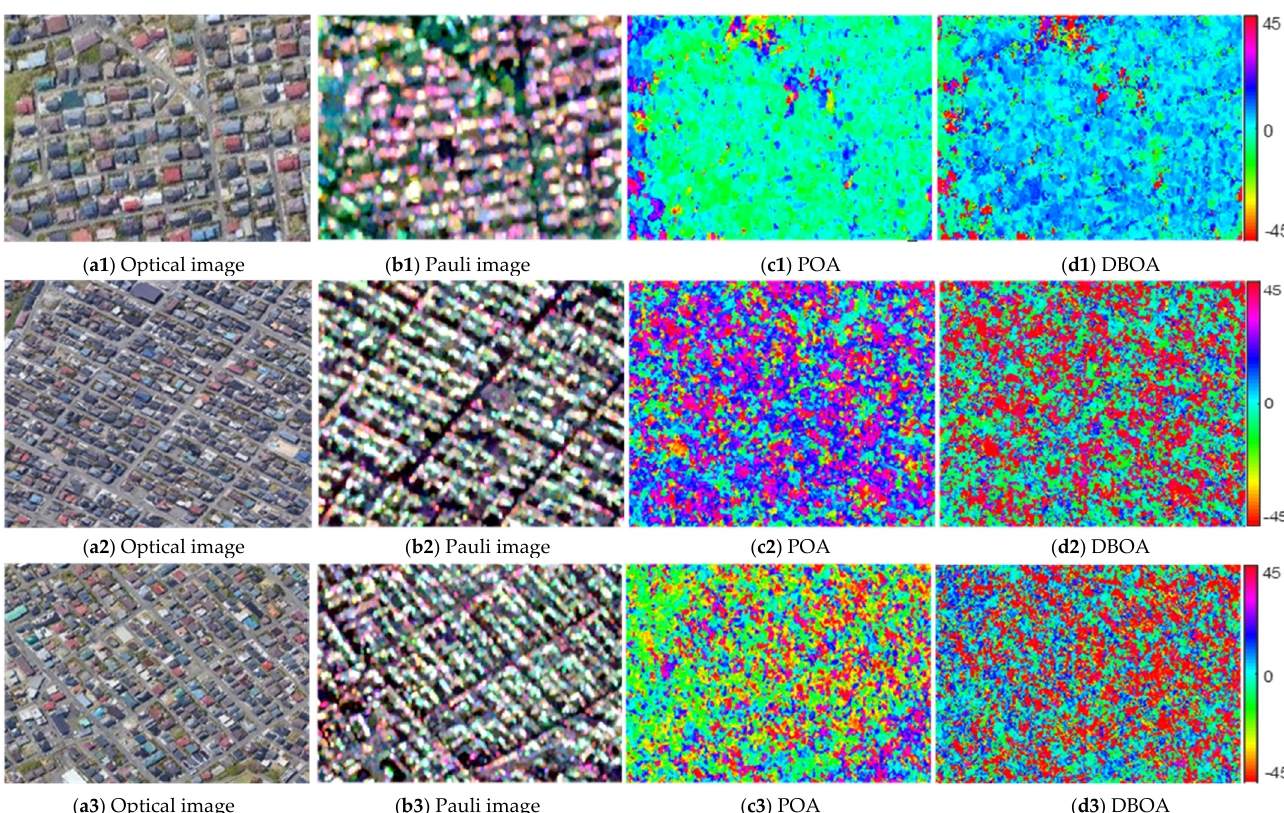
Figure 1. The optical images, Pauli images, polarization orientation angles, and double-bounce orientation angles of three patches selected from airborne X-band PiSAR data. Three patches of buildings are oriented in different directions. The orientation angle of ( a1 ) is around 5 degree, ( a2 ) is 35 degree, and ( a3 ) is 45 degree. ( a1 – a3 ) are the optical images of three different patches and (b1-b3) are the Pauli images. The POAs of three different patches are shown in ( c1 – c3 ), while the DBOAs are shown in ( d1 – d3